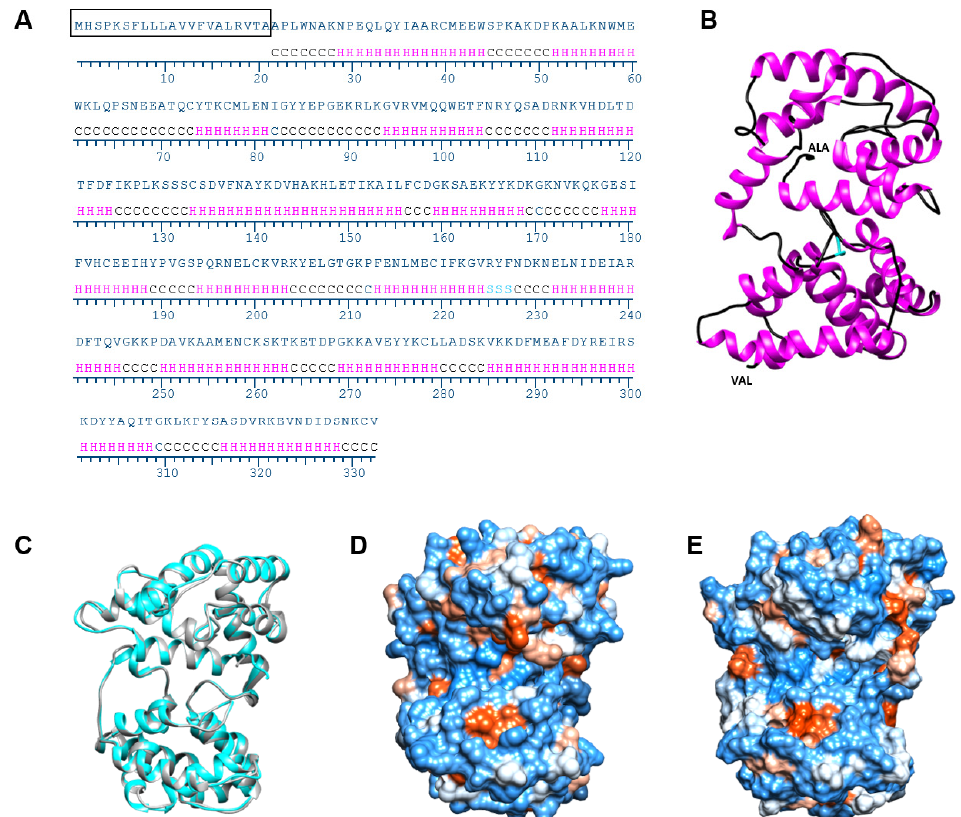
Figure 5. Structural model of AlboD7L1. ( A ) Secondary structure prediction of AlboD7L1 using I-TASSER software. Prediction for coils (C), helixes (H), and strands (S) are indicated. ( B ) Tertiary structure model of AlboD7L1 predicted by I-TASSER and visualized in Chimera software. N-terminal is indicated by ALA-1, and C-terminal is shown as VAL-311 of the mature protein sequence. Coils and helixes are depicted in black and magenta, respectively. The three amino acids predicted to form a strand are represented in cyan. ( C ) Superposition of AeD7L1 (PDB ID: 3DXL, shown in grey) and protein structure model of AlboD7L1, represented in cyan, shows an overall similar helix structure. ( D ) Hydrophobicity surface potential of AeD7L1 (PDB ID: 3DXL) generated by Chimera software with blue being positive and red being negative. ( E ) Hydrophobicity surface potential of the AlboD7L1 model.